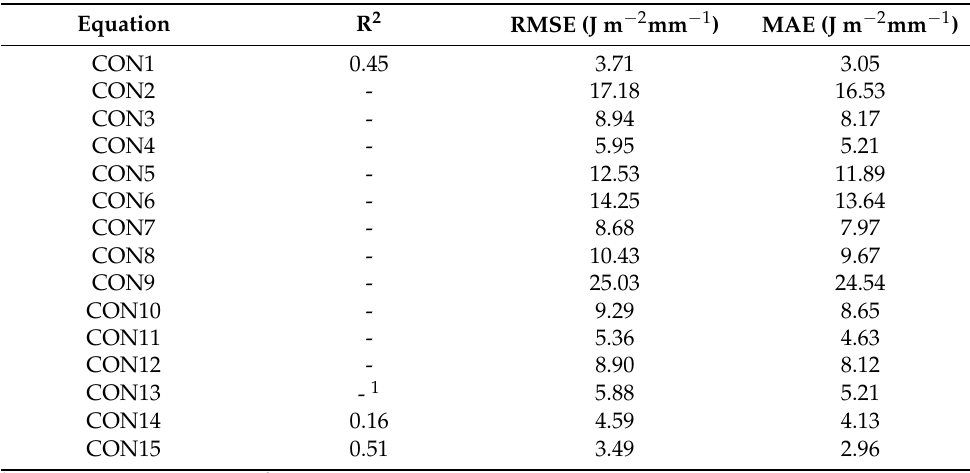
Figure 6. Statistical analysis results of 15 KE con –I r relationships with observed data. Table 5 . Statistical analysis of 15 KE con –I r equations in the literature.